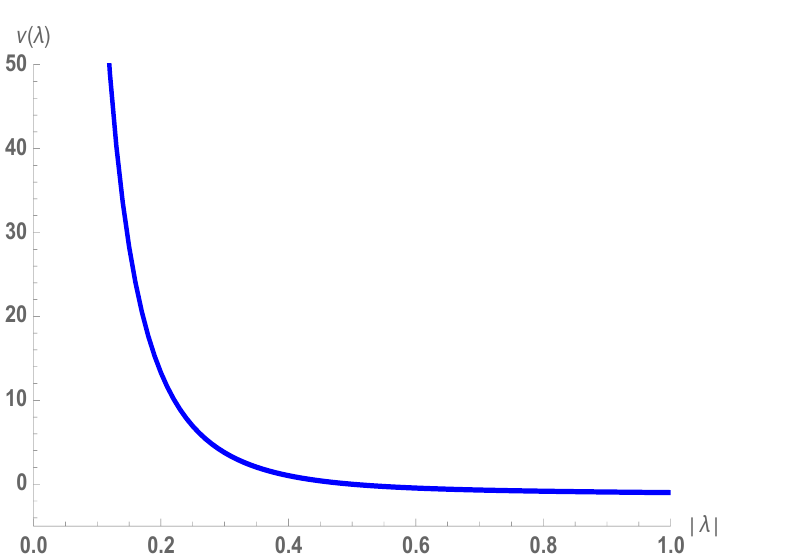
Figure 29. (cid:23) ( (cid:21) ) as a function of j (cid:21) j . The function (cid:23) ( (cid:21) ) appears in the equation for the (cid:12)rst order line (C.3) in the m F = 0 section of the N = 2 phase